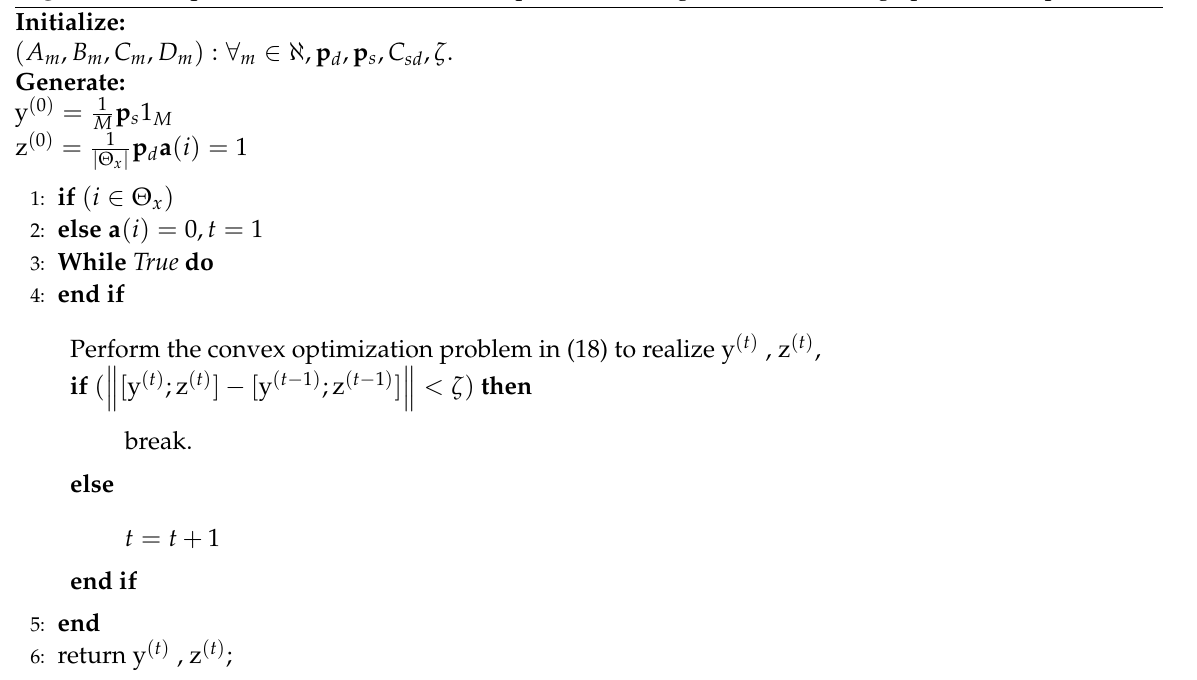
Algorithm 2 Sequential Convex Estimation Optimization Algorithm for solving optimization